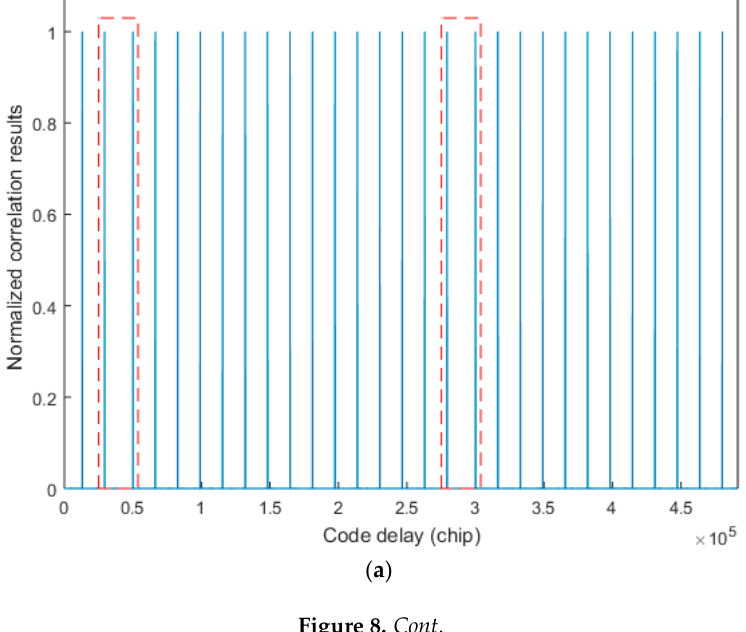
Figure 8. Correlation using the matched filter method: ( a ) autocorrelation results and ( b ) cross- correlation results.